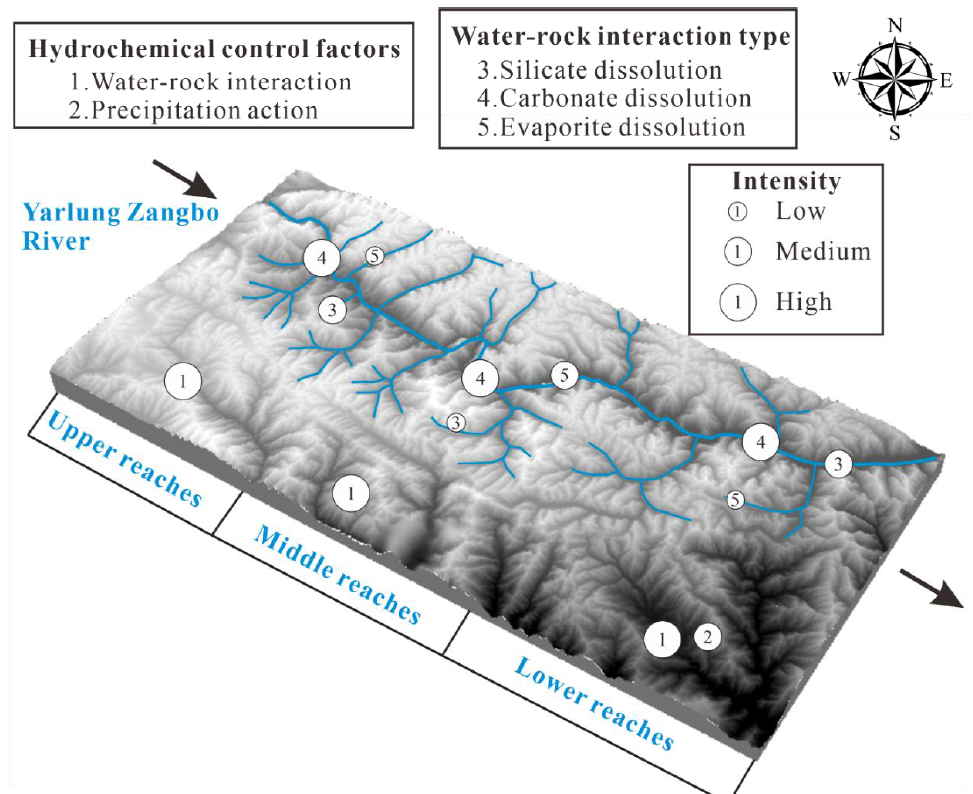
Figure 16. Schematic diagram of hydrochemical control factors in the middle and lower reaches, middle reaches and upper reaches of Yarlung Zangbo River. Table 4. Comparison of hydrochemical characteristics between the lower reaches and the middle and upper reaches of the Yarlung Zangbo River.